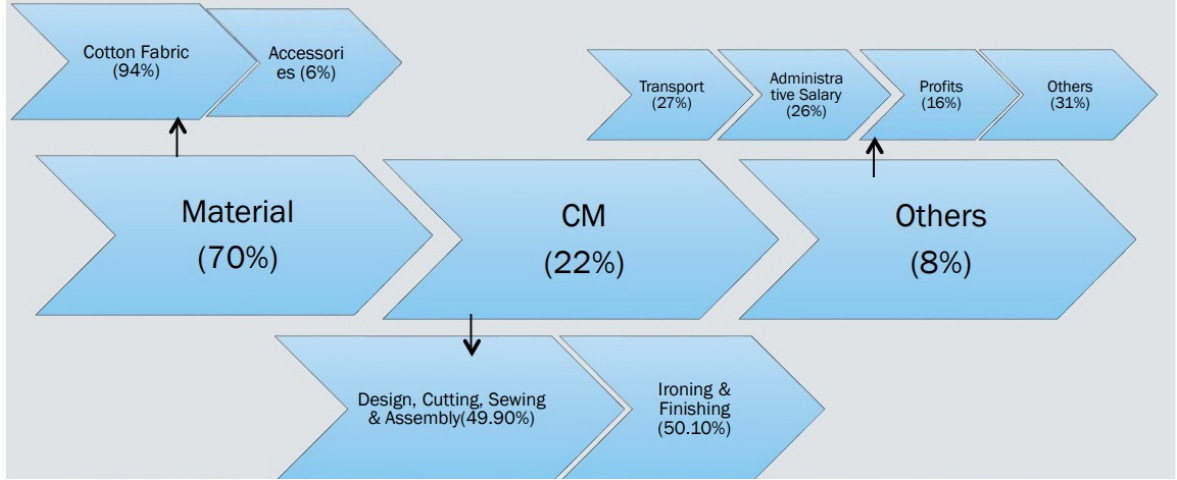
Figure 4: Value Creation Activities by Bangladeshi Knitted Cotton T-Shirt Manufacturers (FOB $2 To $3) Source: Adapted from “Corporate Governance and Sustainability of the Global Value Chain: Bangladesh Ready-Made Garment Industry”, by Nachum et al., 2017, p. 14.